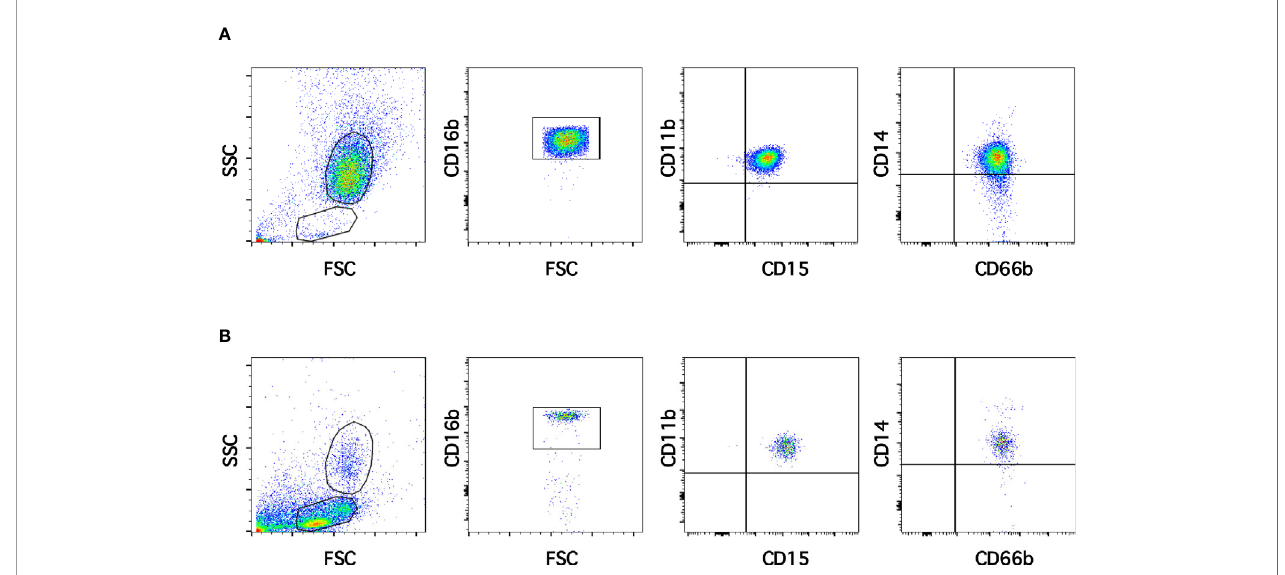
FIGURE 1 | Low-density neutrophils are present in blood of healthy individuals. Leukocytes in blood from young healthy donors were separated by density gradient centrifugation into neutrophils (A) and mononuclear cells (B) . Puri fi ed neutrophils (A) were then analyzed by multicolor fl ow cytometry (FACS) for expression of CD16b, CD11b, CD15, CD14, and CD66b. Similarly, mononuclear cells (B) were analyzed with the same FACS parameters. A small number of cells with the same light scattering properties and the same membrane expression of molecules as neutrophils were found among MNC. Tracings are representative of more than 10 experiments with similar